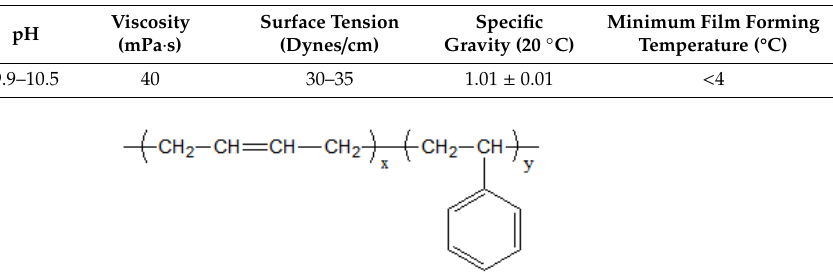
Table 1. Properties of SBR latex.